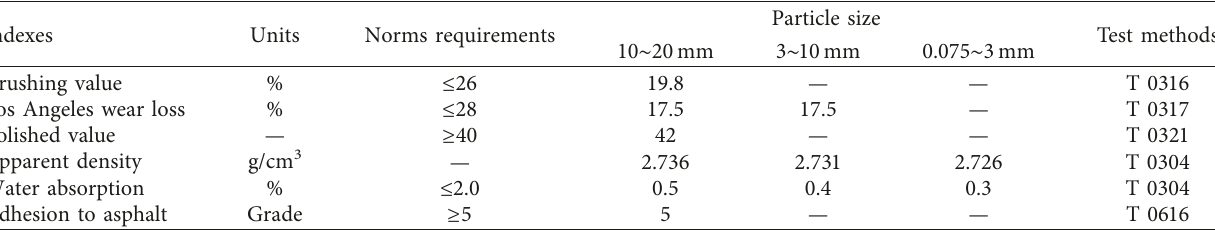
Table 5: Physical properties of the virgin aggregate.